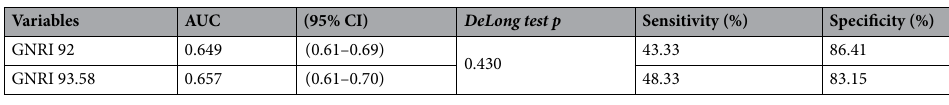
Table 2. Sensitivity and specificity of different GNRI cut-off value. Outcome: